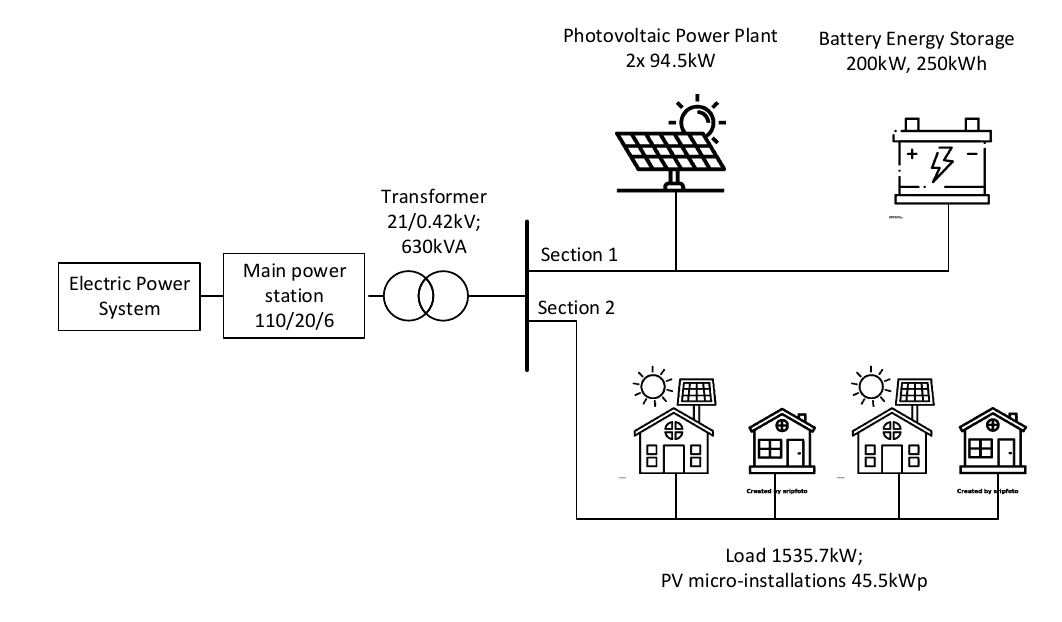
Figure 4. Diagram of the tested network.